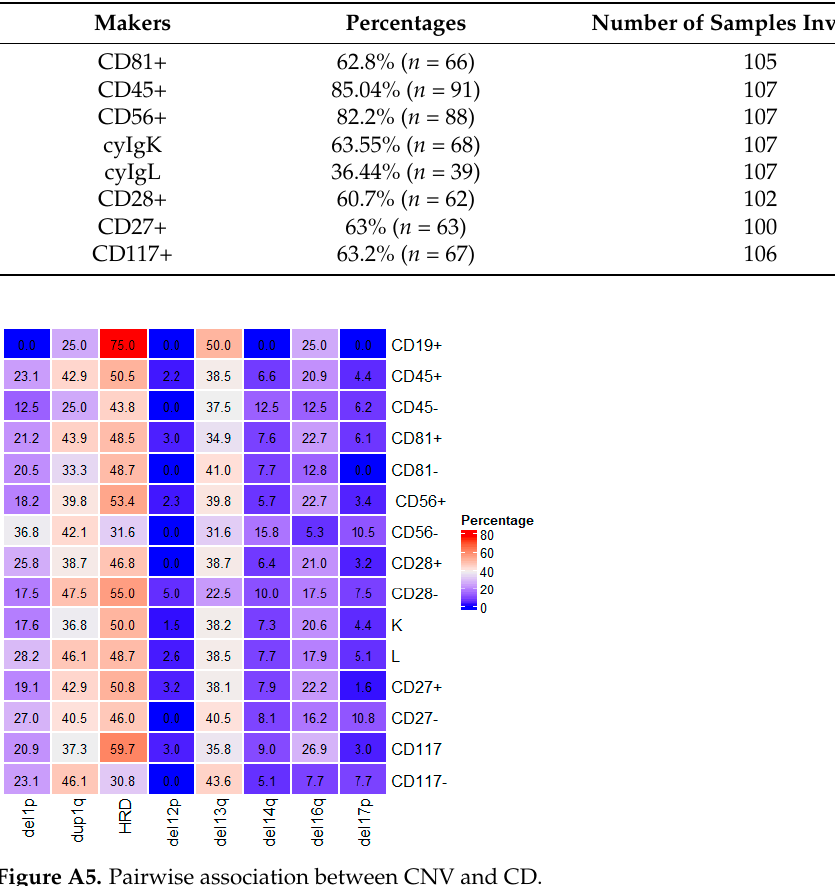
Figure A5. Pairwise association between CNV and CD.